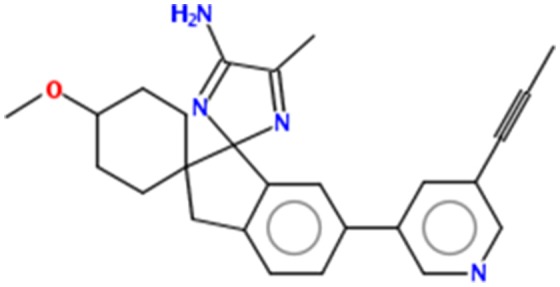
Chemical structure of AZD3293.